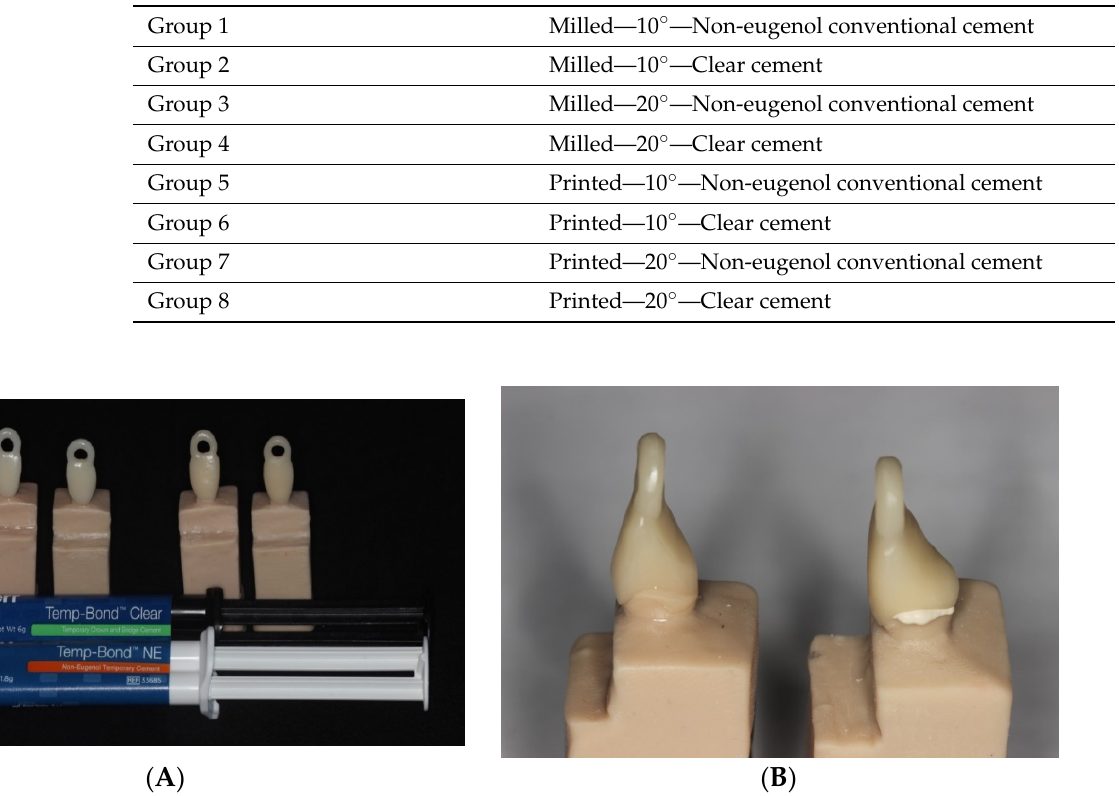
Figure 4. Cementation of temporary crowns with Kerr Temp-Bond NE cement and Kerr Temp- Bond clear cement. ( A ) Temporary crowns and cement used for cementation ( B ) Crowns after cementation.